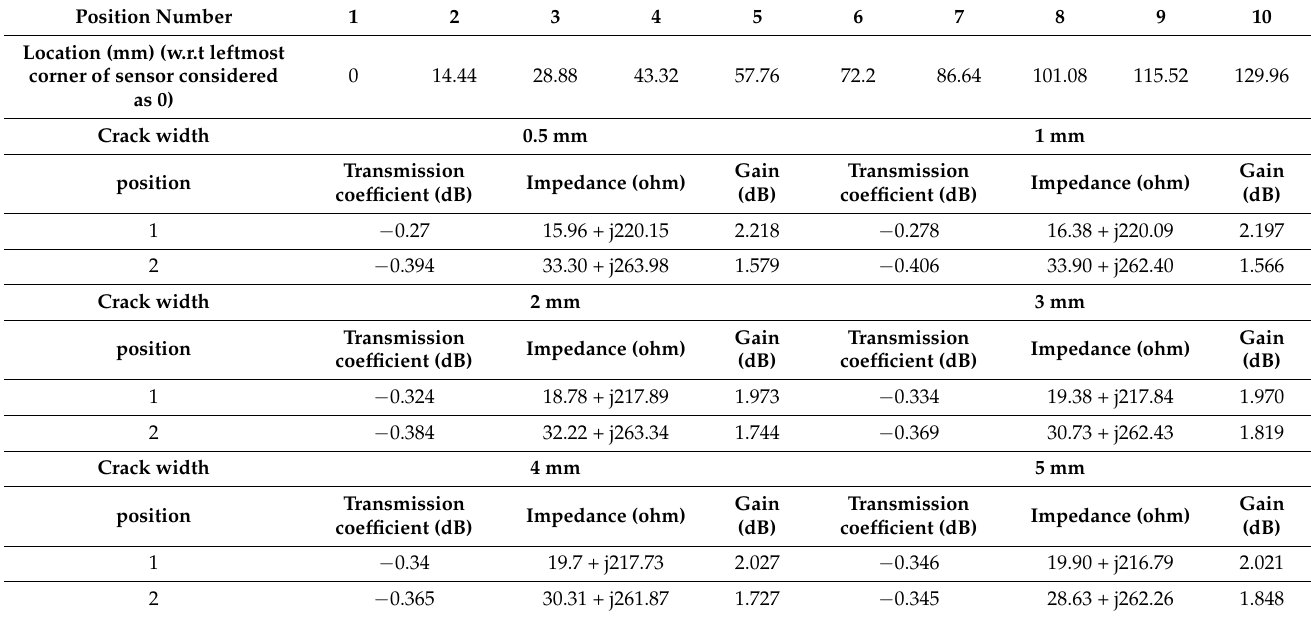
Table 3. Simulated input parameters for Vertical Crack Orientation (first two positions).